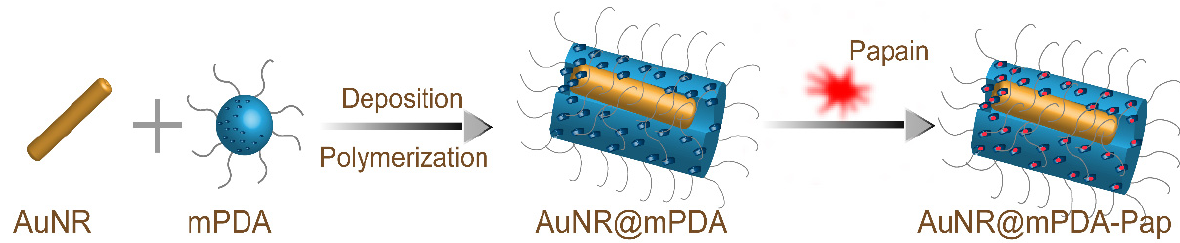
Figure 4. Schematic illustrations of preparation of mPDA encapsulated gold nanorods for papain loading.